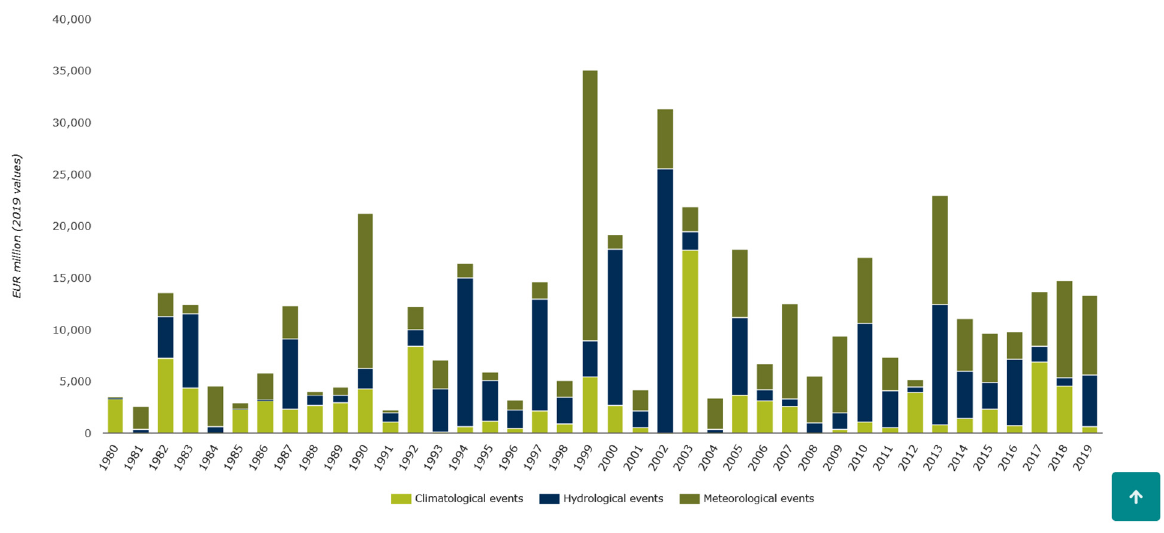
Figure 1. Economic damages caused by weather and climate-related extreme events in Europe (EU-28, 1980–2019). Source: EEA (2021). Reprinted with the permission from EEA. The standard EEA’s copyright legal notice applies.